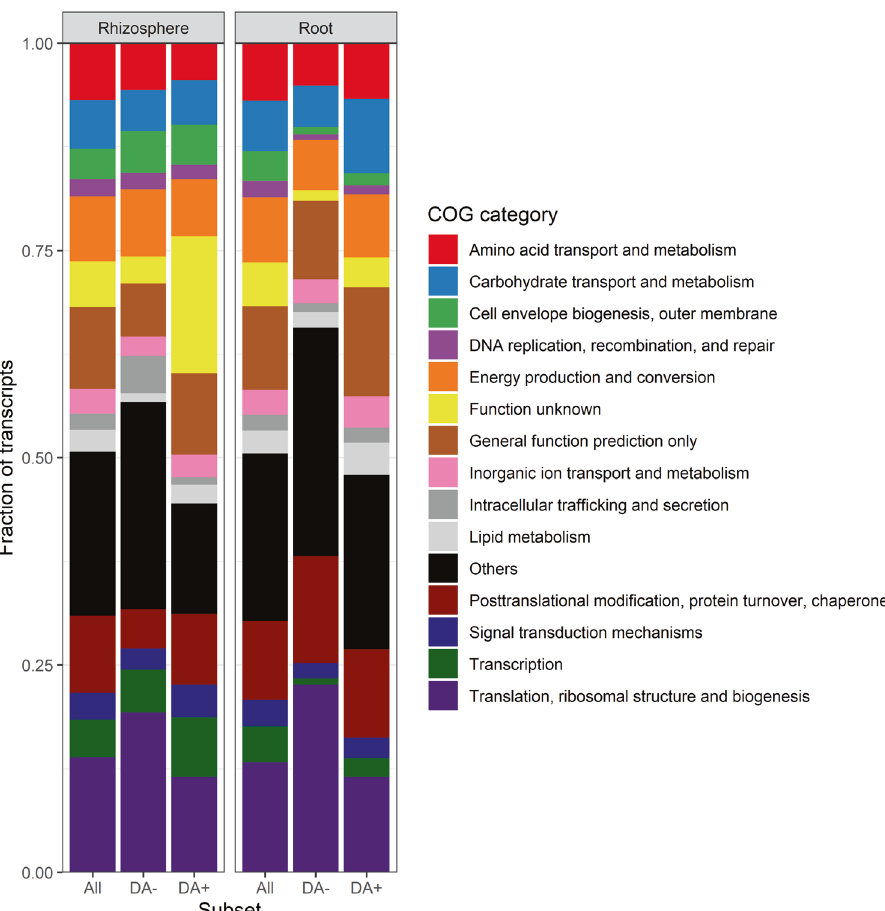
Fig. 4 Functional af fi liations of transcripts. Stack bar chart comparing the functional af fi liations (COG category) of transcripts associated in ( A ) roots and ( B ) the rhizosphere across all samples vs. among transcripts positively (DA + ) or negatively (DA-) differentially abundant. The transcripts not classi fi ed at this level ( “ NULL ” ) were